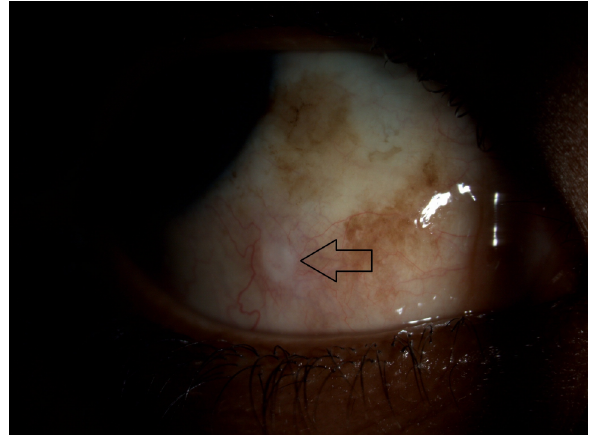
Figure 1: At presentation. External photograph of the right eye reveals conjunctival congestion in the inferonal quadrant of the eye with a prominent area of scleral protuberance (arrow) signifying the site of the bee sting